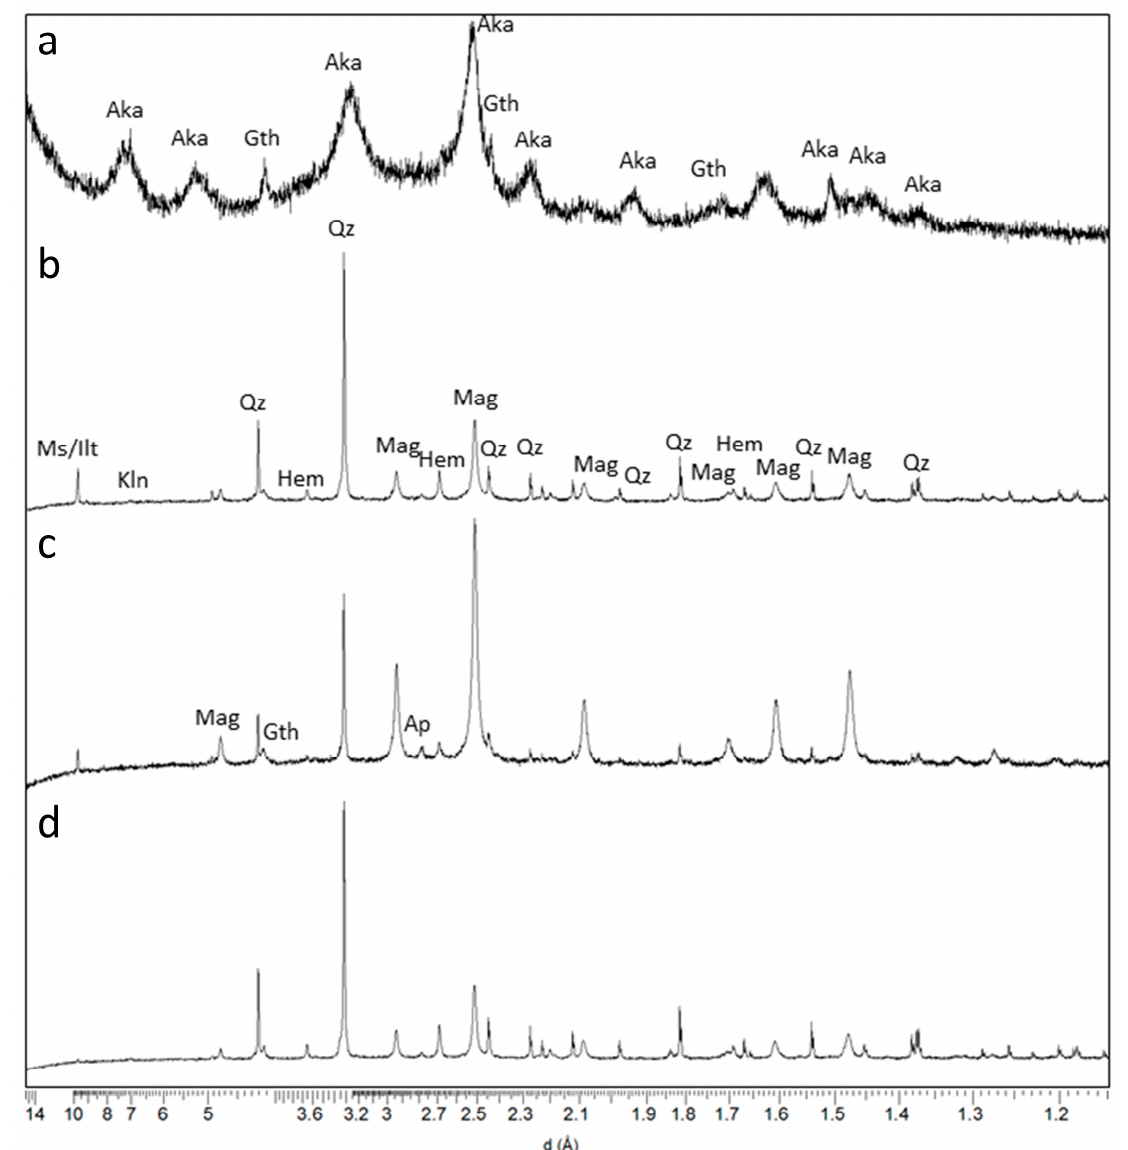
Figure 5. X-ray diffraction of the solid phase of long-term enrichment cultures using the synthetic Fe(III) source. ( a ) Synthetic Fe(III) oxide used as an iron source for enrichment cultures. A pronounced amorphous hump (from ~6 to 2 Å) points to the predominance of amorphous phases, with crystalline akaganeite (Fe 3+8 (OOH) 16 Cl 1.25 · nH 2 O, Aka) and goethite (FeOOH, Gth) as minor phases. ( b – d ) Solid phase of enrichment cultures that turned black and magnetic after 170 days, showing mainly crystalline, mixed-valency iron oxide magnetite (FeO · Fe 2 O 3 ) with a diagnostic peak at ~2.53 Å. Other crystalline phases include the common riverine sediment minerals quartz (Qz), muscovite/illite (Ms/Ilt), kaolinite (Kln), fluorapatite (Ap), and the iron oxides hematite (Hem) and goethite (Gth). ( b ) GNR-M-B, ( c ) GNR-M-C, and ( d ) GNR-BL-A. See Table 1 for more details on these